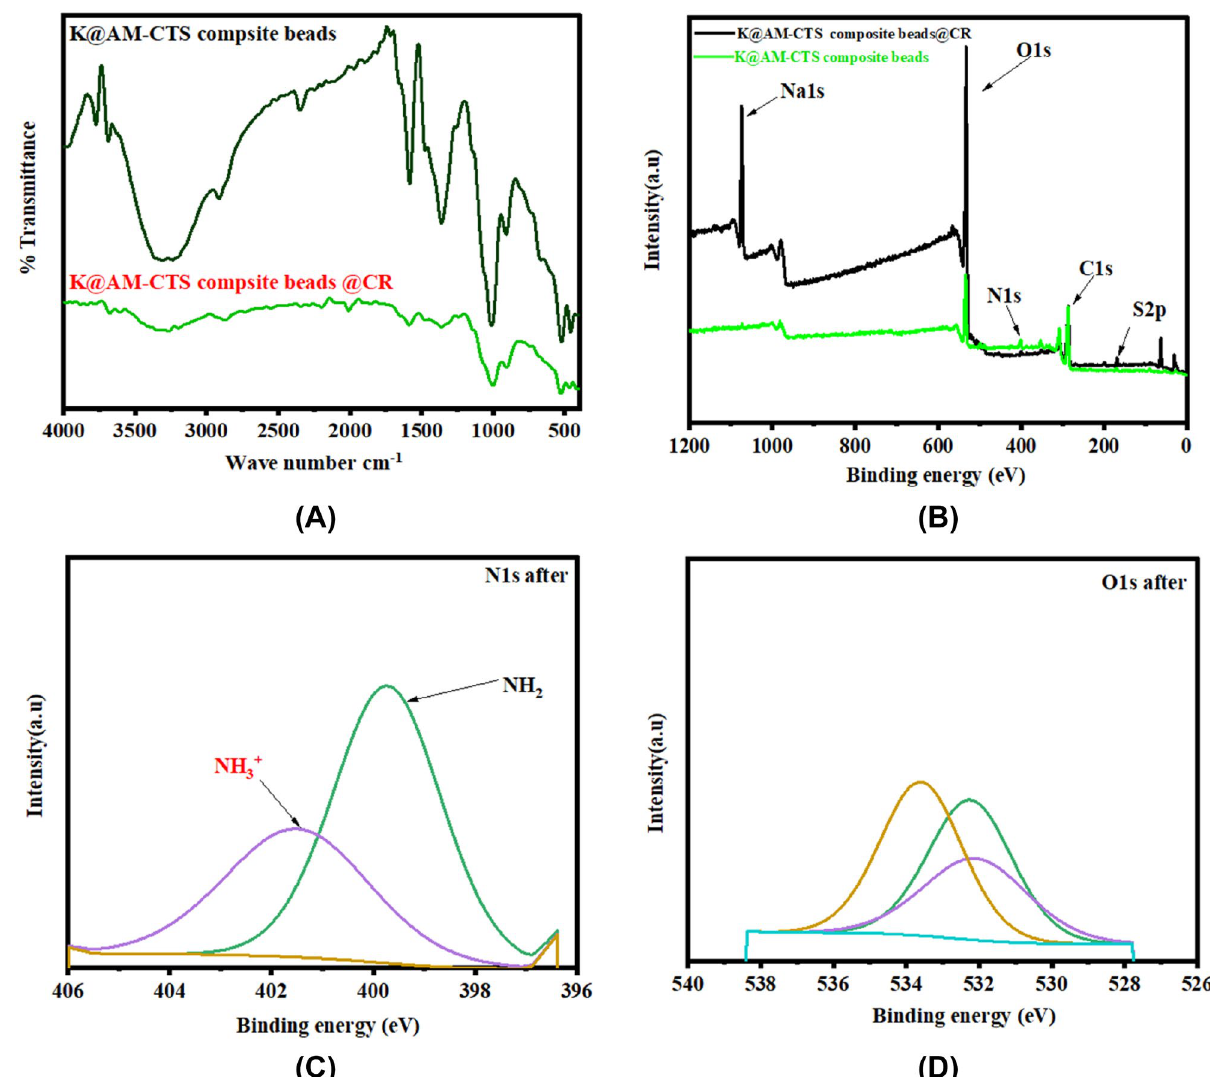
Figure 10. ( A ) FTIR of K@AM-CTS composite beads before and after adsorption, ( B ) XPS spectra of K@ AM-CTS composite beads before and after adsorption, ( C ) N1s and ( D ) O1s after adsorption of CR